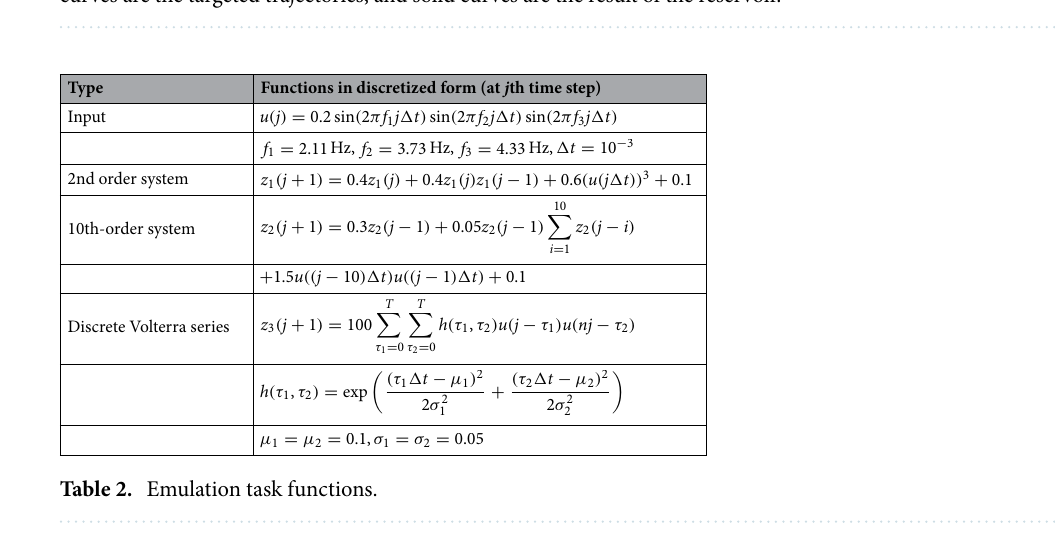
Figure 4. Proof-of-concept experiment showing the emulation task with the origami reservoir. ( a ) The experimental setup depicting the excitation table and paper-based Miura-ori reservoir with sensor node markers attached. The base of the reservoir is fixed to the base plate of the exciter. Notice that additional mass are added at random locations to break the origami’s symmetry. ( b ) The base-plate displacement/input signal (u(t)) and recorded nodal displacements in y-direction. ( c ) Examples of trajectories generated in the emulation task including (from top to bottom) input signal u(t), 2nd-order, 10th-order system, and Volterra series. Dashed curves are the targeted trajectories, and solid curves are the result of the reservoir.